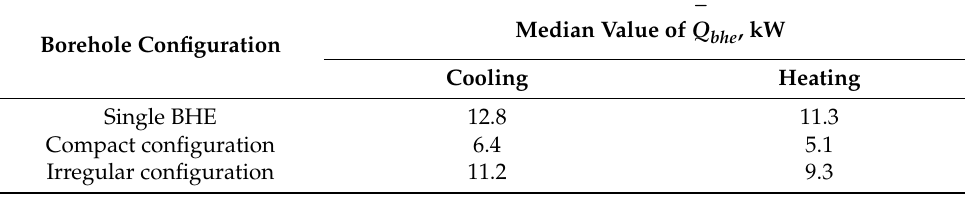
Table 4. Median values of heat transfer rates per borehole ( Q bhe , kW) for test BHE